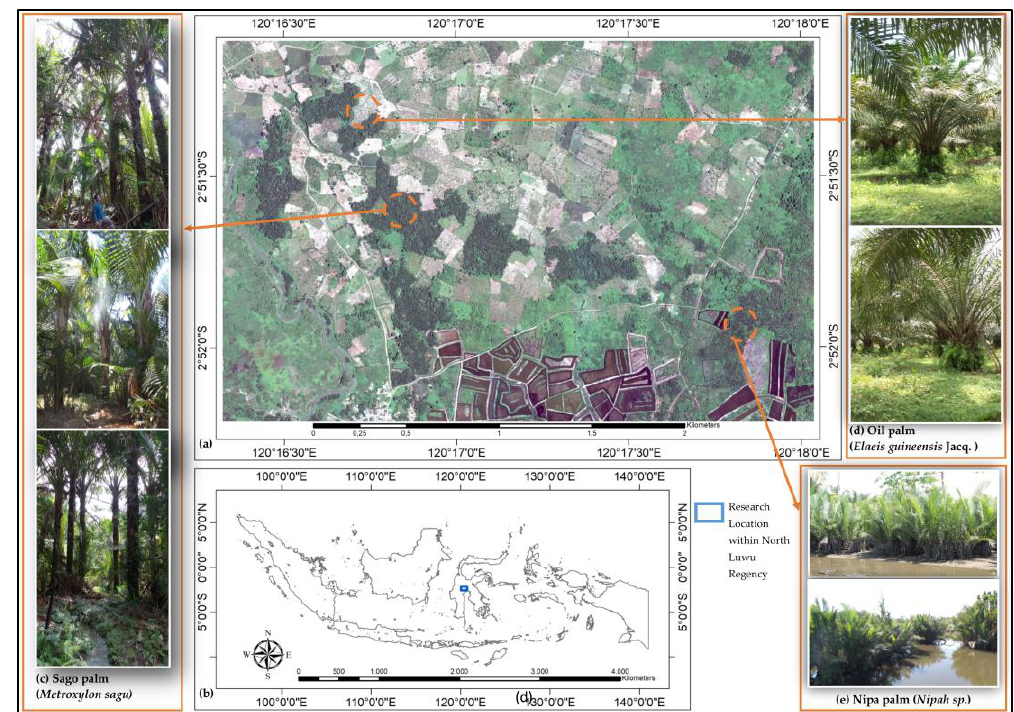
Figure 1. ( a ) Natural color composite of Pleiades-1A imagery shows heterogeneous land use land cover (LULC) including sago palm clumps and single sago palm trees. ( b ) Research location in North Luwu Regency, South Sulawesi Province, Indonesia. ( c ) Field photo showing sago palm, ( d ) oil palm ( Elaeis guineensis Jacq.), and ( e ) nipa palm ( Nipah